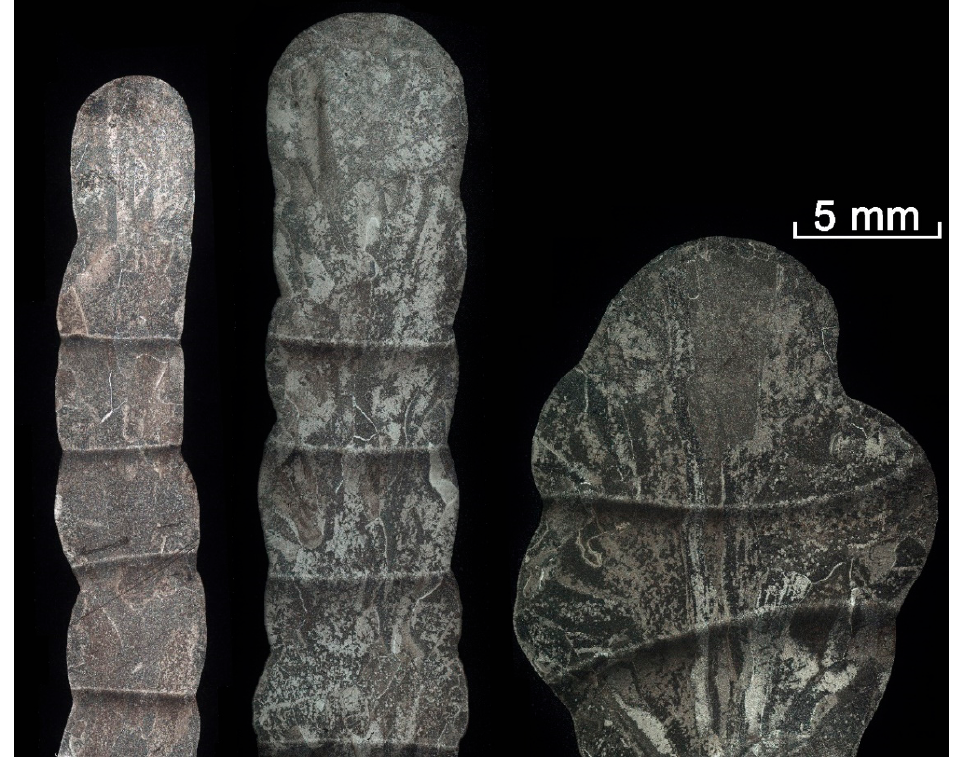
Figure 12. Walls: CMT—on the left, CSC—in the center, DCEN—on the right. The microstructure images (Figure 13a,c,e) represent an α -basketweave structure within the columnar prior β -grains. Such a microstructure was formed due to repeated rapid heating and cooling that takes place in the WAAM process [43]. The α -lath thickness is about 2 µ m and does not differ between the three investigated wall